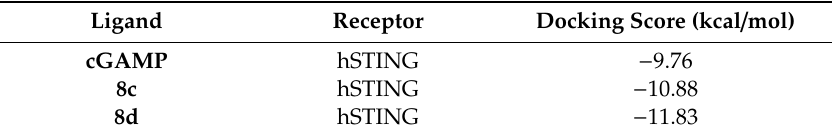
Table 2. The docking scores of OPFV with human